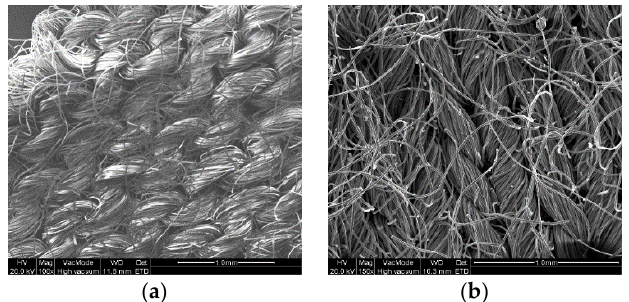
Figure 2. SEM results: ( a ), Knitted cotton fabric; ( b ) PEDOT:PSS/PDMS coated knitted cotton fab- ric.